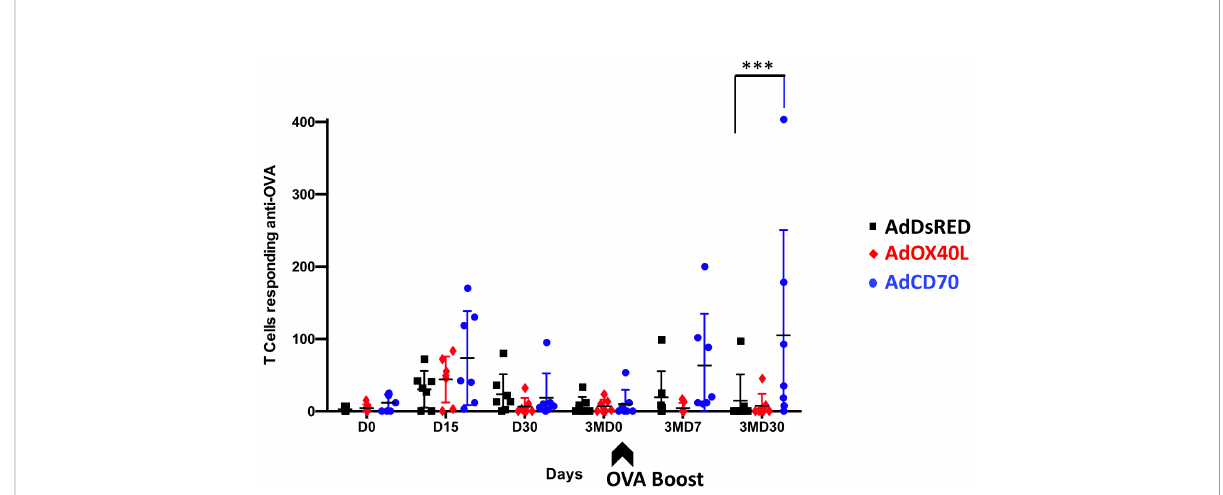
FIGURE 4 Speci fi c IFN- g production to OVA in PBMCs from the three groups of inoculated sheep detected by ELISPOT assay. PBMCs from sheep inoculated with control vector AdDsRed (black), AdOX40L (red), or AdCD70 (blue) were isolated at different times (x axes) and cultured for 48 h in the presence of OVA. The production of IFN- g was measured using an ELISPOT assay. Data are presented as average (± SEM) IFN- g spots above background for 10 6 cells in each treatment group. A positive control of PBMCs activated with 1.25 m g/ml Con-A (Sigma) was always included to validate the ELISPOT assay. ***p < 0.001 Two-way ANOVA with Dunnett ’ s post-test. The black arrow (3MD0) denotes the OVA booster in all